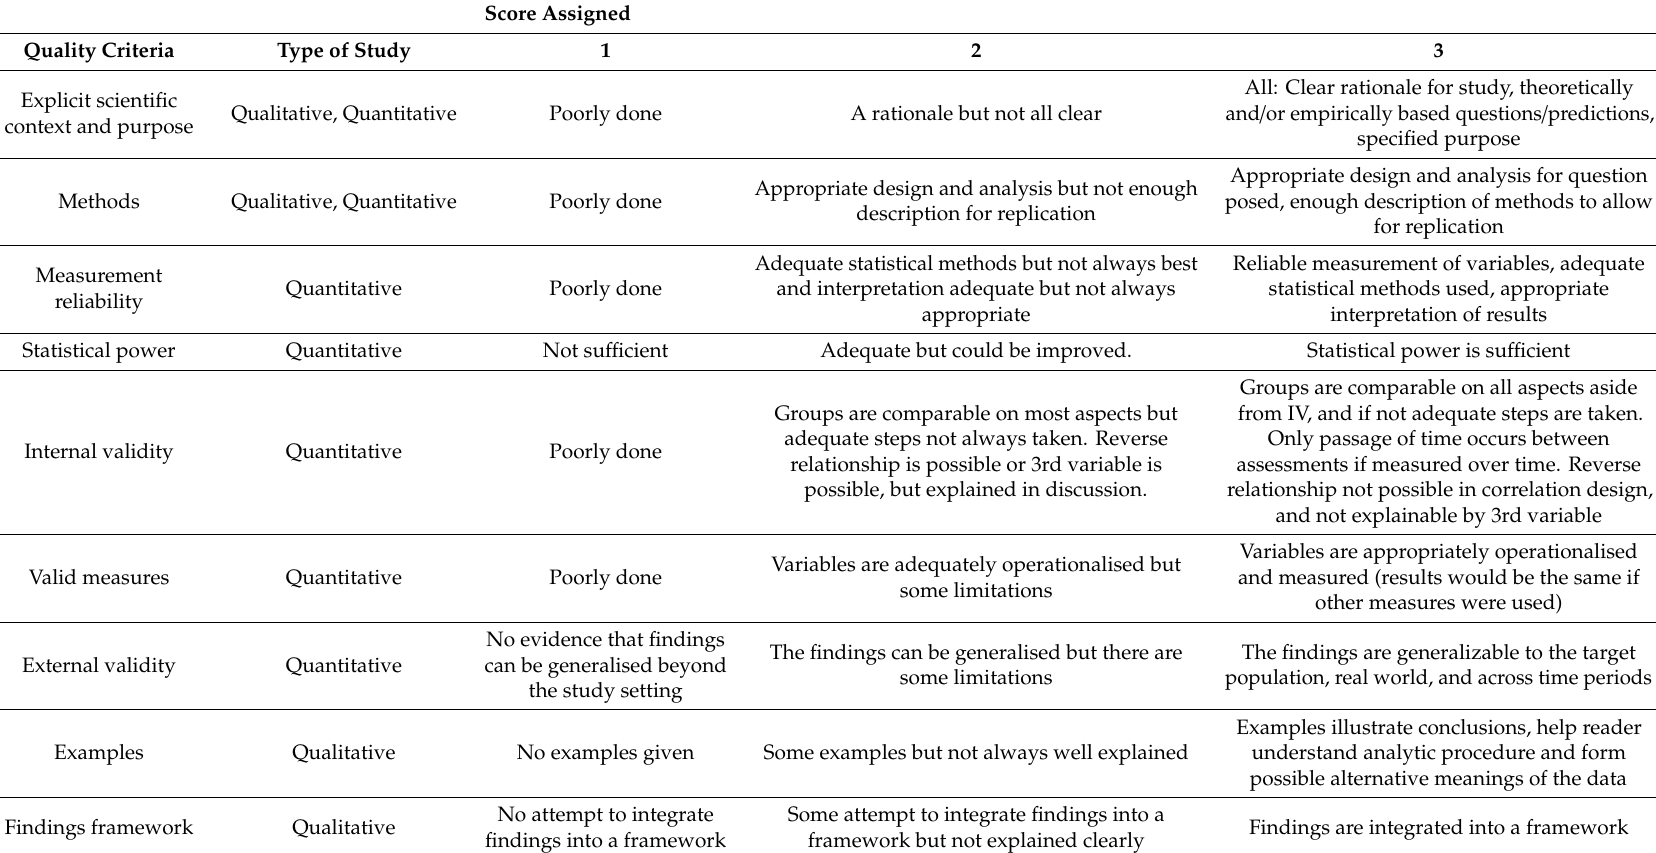
Table A2. Table to show the scoring guidelines used for the quality appraisal, based on criteria by Alderfer et al. (2010)